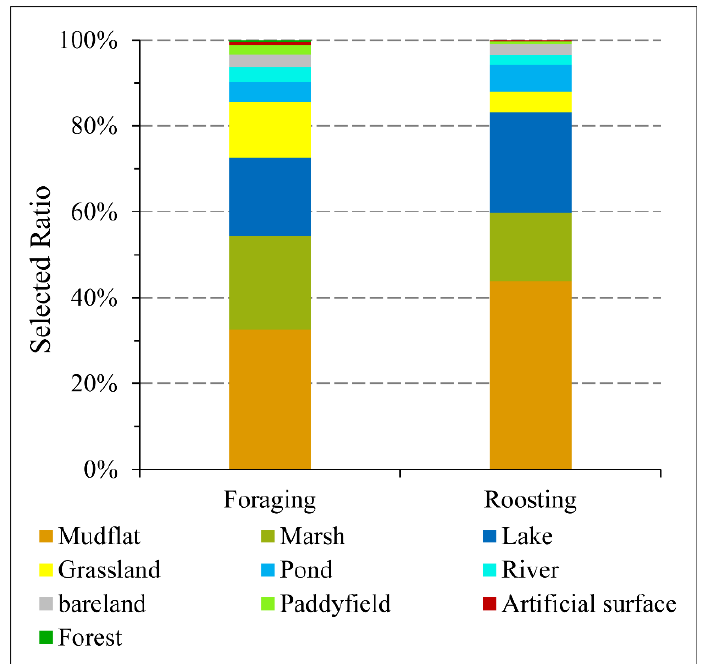
Figure 6. Habitat selection at the point